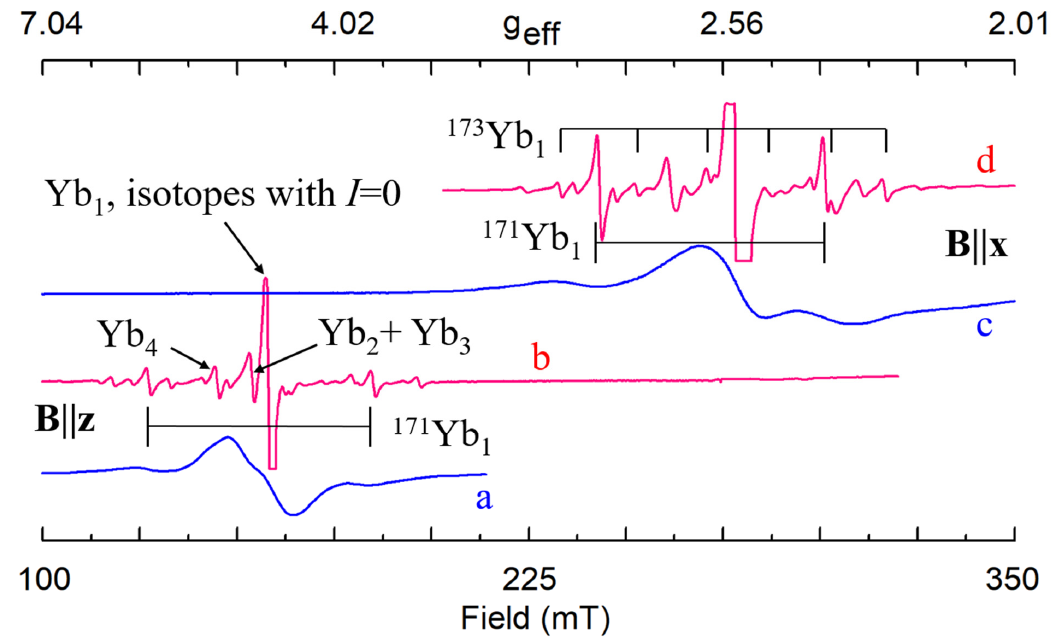
Figure 22. EPR spectra of Yb 3+ in congruent (a, c) and stoichiometric (b, d) LN.